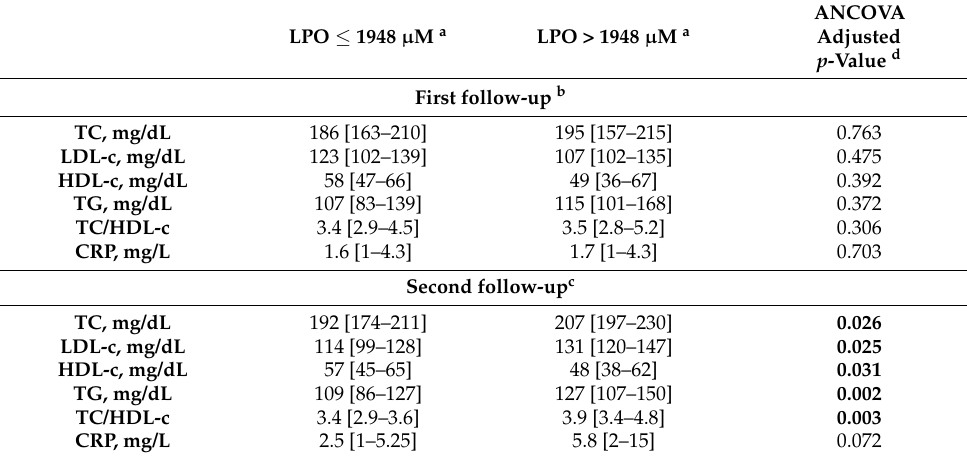
Table 3. Change in plasma lipid and lipoprotein concentrations between baseline and follow-up levels according to lipid peroxidation at